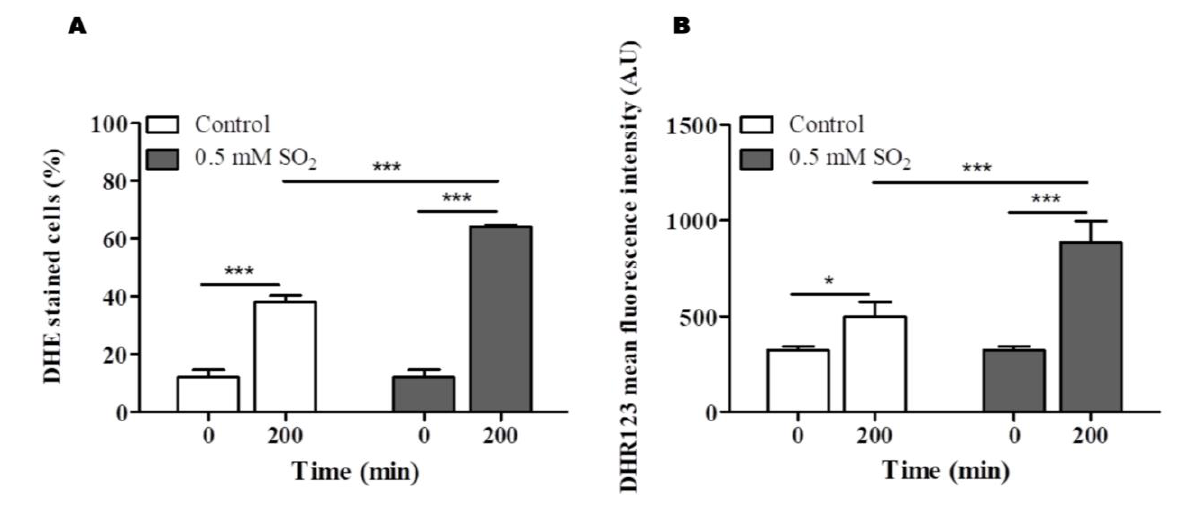
FIGURE 4. Assessment of the intracellular accumulation of ROS in S. cerevisiae BY4741 cells cultivated in MMB medium (at pH 3.5) (white bars) or in this same medium supplemented with 0.5 mM SO 2 (grey bars). Quantification of intracellular ROS accumulation was made based on fluorescence emitted by cells stained with the ROS specific dyes DHE (A) and DHR123 (B) and analysed by flow cytometry. Signifi- cance was determined by two- way ANOVA (*p≤0.05, ***p≤0.001) between cells at time 0 and 200 minutes and between control cells and cells supplemented with SO 2 . Data represents mean ± SEM (the standard error of the mean) of at least three biological independent repli-